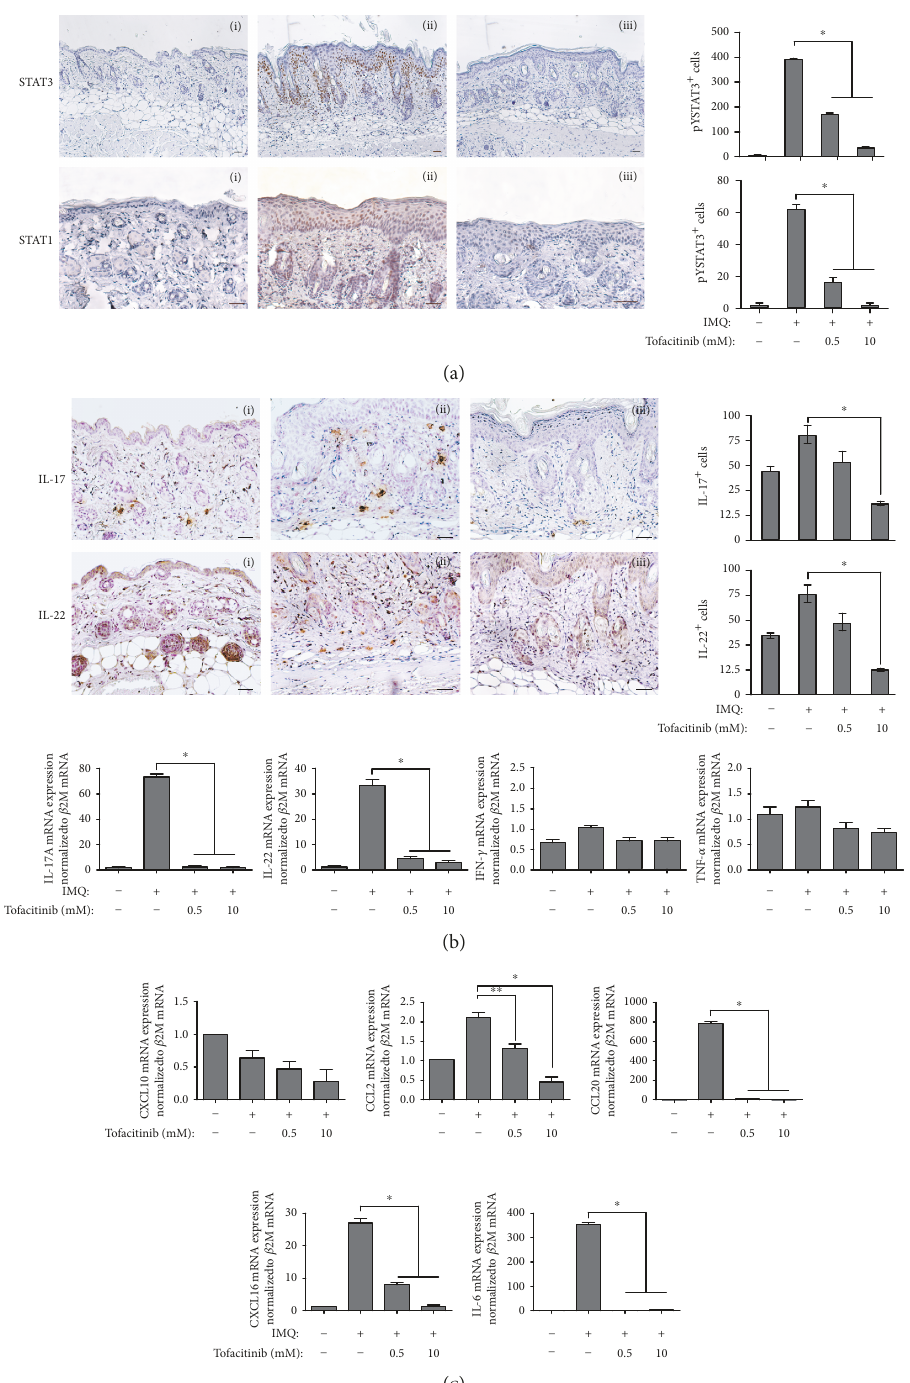
Figure 6: Tofacitinib counteracts IMQ e ff ects in mouse skin. Immunohistochemistry analysis of mouse skin left untreated (i), IMQ-treated (ii), and IMQ-treated in the presence of tofacitinib (iii) shows reduction of STAT1-, STAT3-, IL-17A-, and IL-22-positive cells (a) and (b) after tofacitinib treatment. Sections were counterstained with Mayer ’ s hematoxylin and were visually evaluated by a pathologist experienced in dermatology. Bars, 200 μ M. One of four representative stainings is shown. Graphs show the mean number of positive cells ± SD per three sections per experimental group ( n = 10 mice). ∗ p < 0 01 . In (b), graphs show real-time PCR analyses of IL-17A, IL-22, IFN- γ , and TNF- α performed on pooled mRNA samples ( n = 10 ) of mouse skin treated as indicated. ∗ p < 0 01 . In (c), graphs show real- time PCR analyses of CXCL10, CCL2, CCL20, CXCL16, and IL-6 performed on pooled mRNA samples ( n = 10 ) of mouse skin treated as indicated. ∗ p < 0 01 , ∗ p < 0 05